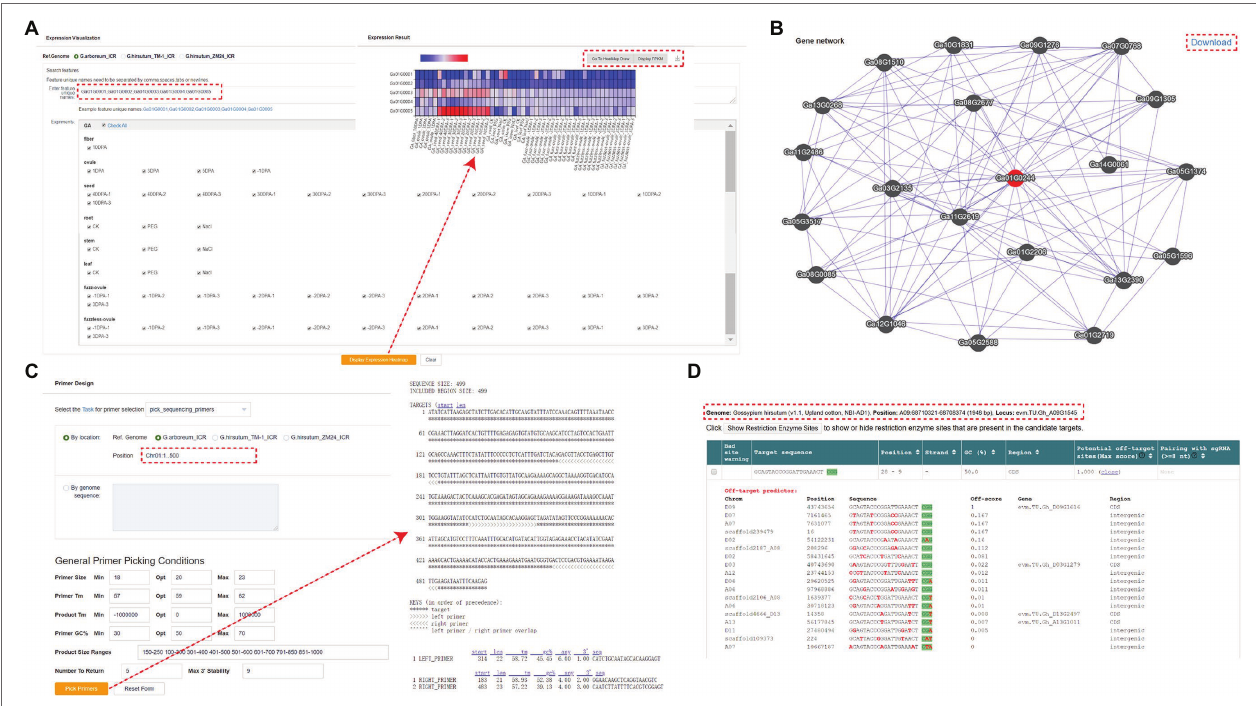
FIGURE 4 | Tools in GRAND. (A) A heatmap showing gene expression search results. Each row represents the expression data of a gene across many samples, and each column shows the expression in a particular sample. (B) Co-expression network search results. The network shows the top 20 nodes near the target gene, and the corresponding information can be viewed by clicking. (C) Primer design page. (D) TargetDesign tool for designing primers for CRISPR/Cas9/Cpf1 genome